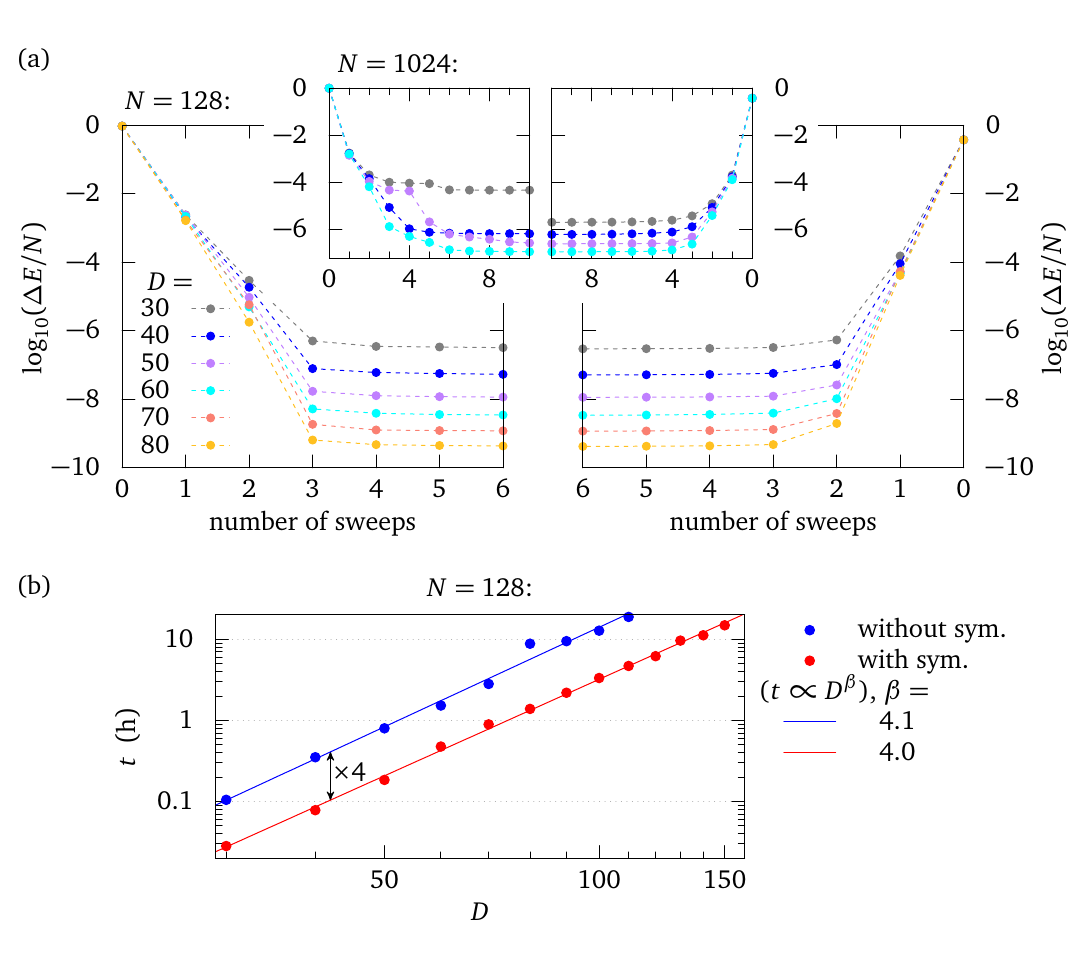
Figure 52: (a) Convergence to the ground state energy of the 1D critical Ising model in a bTTN using a single-tensor update without any inbuilt symmetries (left), compared = ¯ ∂ = D / 2 (right). to a single-tensor update with inbuilt Z symmetry and fixed ¯ ∂ e o 2 Plotted is the error of the ground state energy per site ∆ E / N as a function of the number of optimization sweeps for different bond dimensions D and different system sizes N . (b) Runtime comparison of the two algorithms from (a), demonstrating the faster performance of the algorithm with